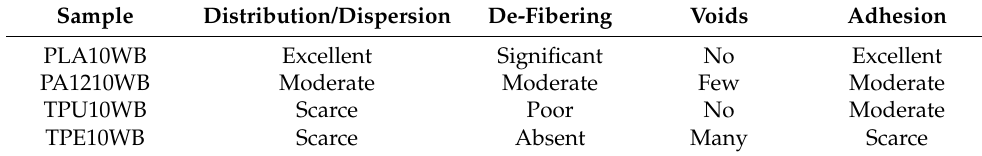
Table 5. Qualitative resuming of the morphological properties of WB-based composites.